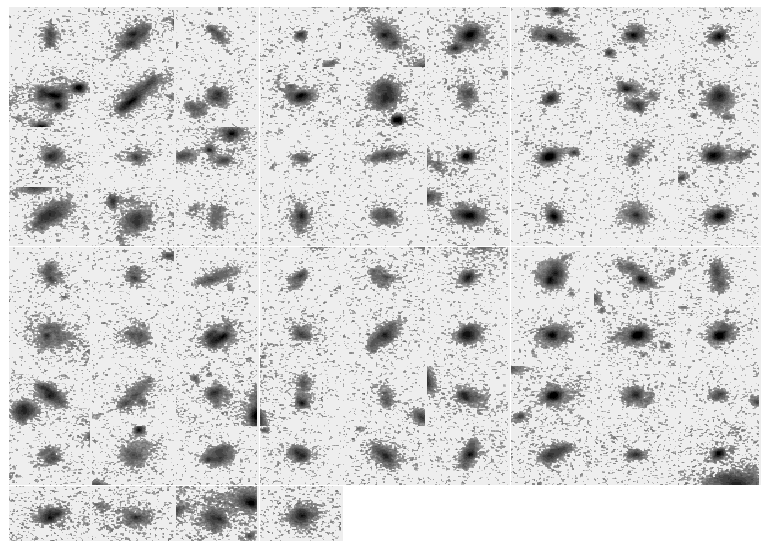
Fig. 6. HST/WFC3 H -band images of ULIRGs at 1 : 8 < z < 3 from the COSMOS field of the 3D-HST survey. The size of each image is 4 ′′ (cid:2) 4 ′′